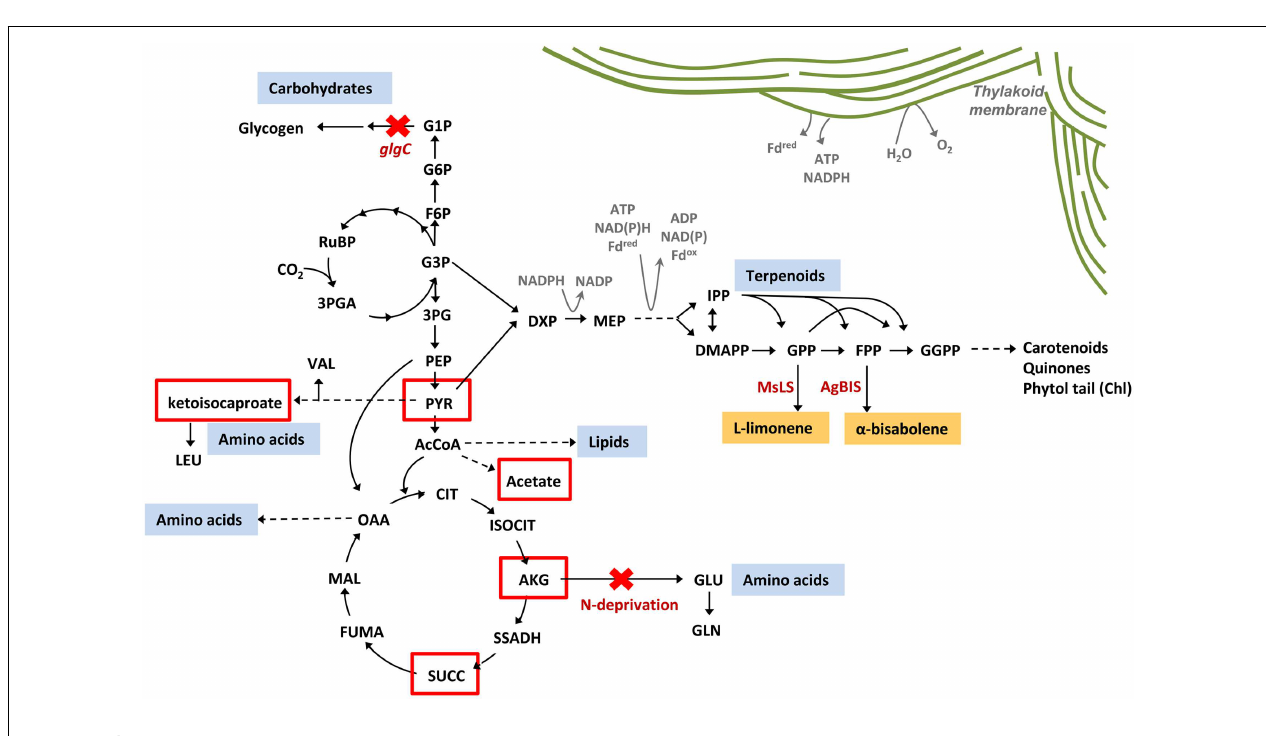
FIGURE 10 | Metabolic redistribution in Synechococcus sp. PCC 7002 upon simultaneous blocks to protein and carbohydrate sinks . Protein (amino acids), carbohydrates (mainly glycogen), and lipids represent the major metabolic sinks in Synechococcus sp. PCC 7002. When metabolic flux to glycogen and amino acids were simultaneously blocked, through inactivation of ∆ glgC and elimination of nitrogen from